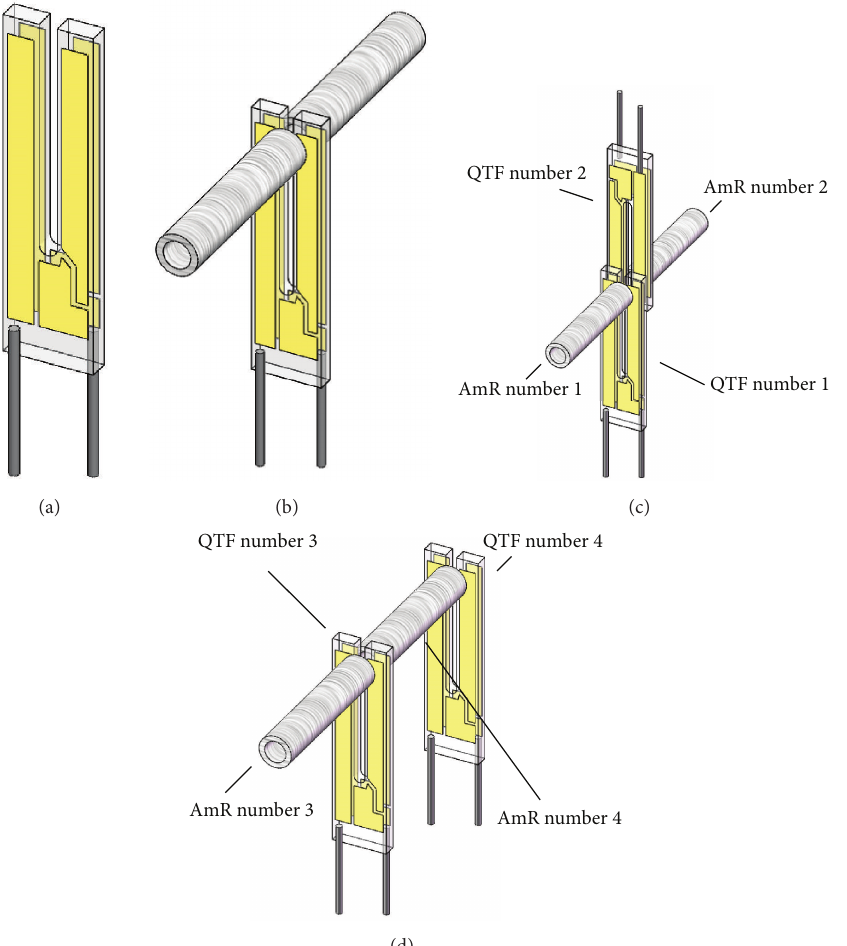
Figure 4: (a) Single bare QTF based spectrophone, (b) single QTF based “on-beam” spectrophone, and (c), (d) multi-QTF based “on-beam” spectrophones. The geometric parameters of all the AmRs used in Figure 4 are 4.4 mm in length and 0.6 mm in inner diameters, respectively.